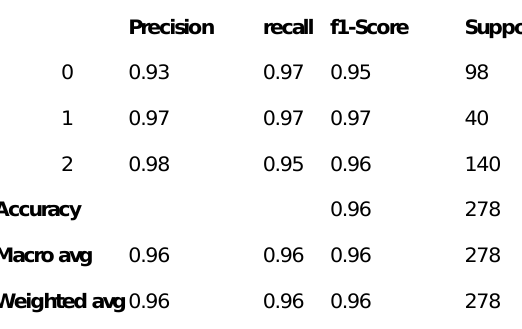
Figure 3. Confusion Matrix of MLP Classifier.